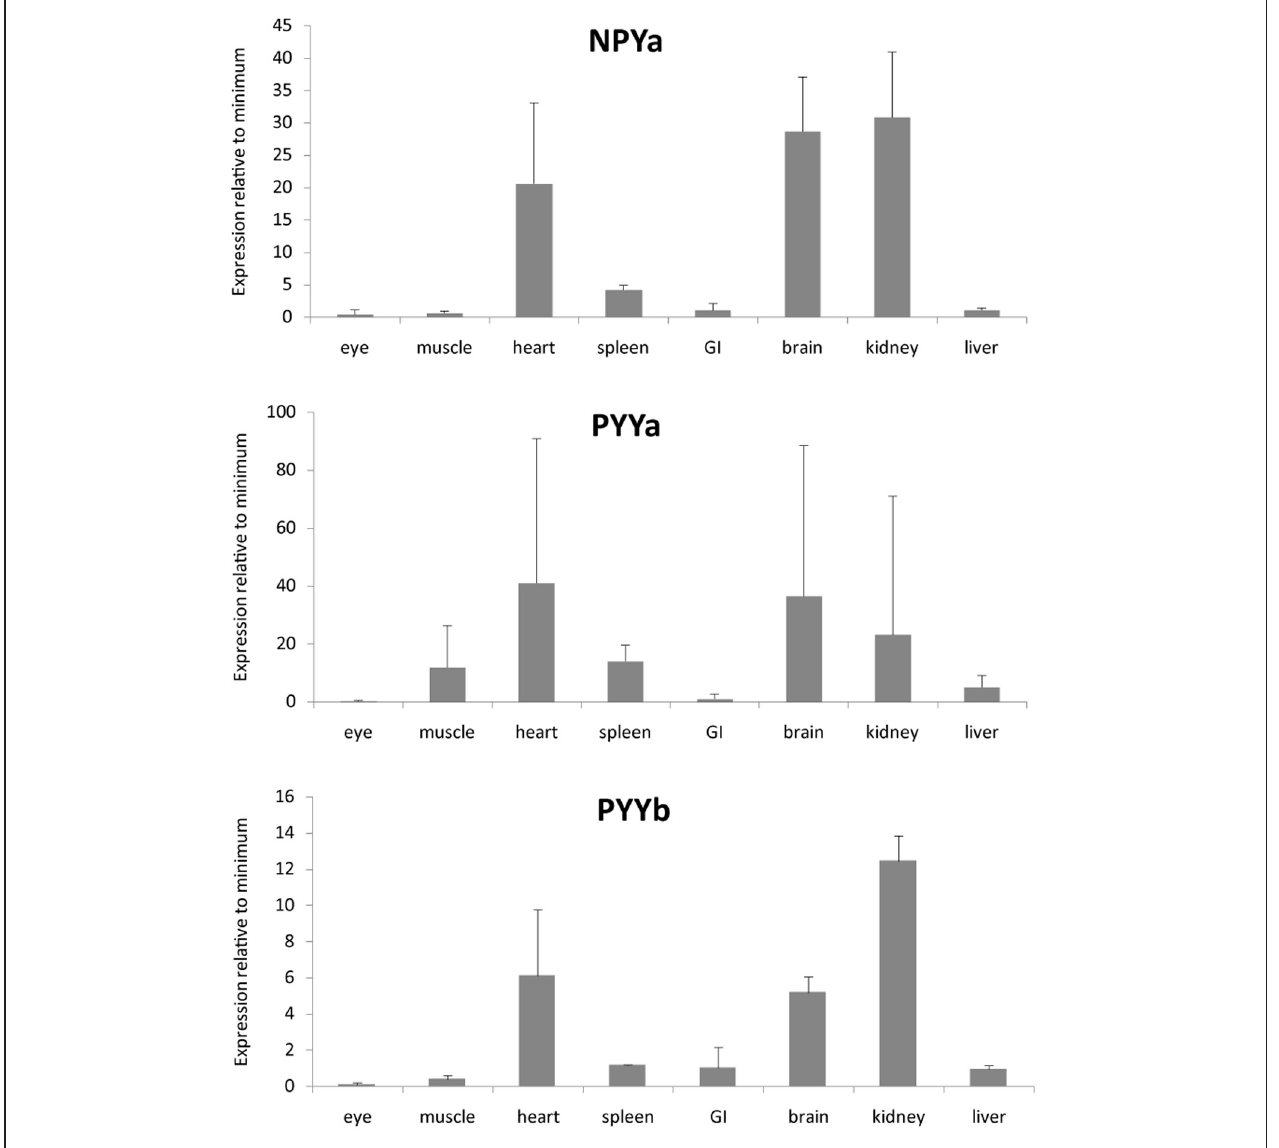
FIGURE 3 | Expression data for neuropeptide Y peptides in a panel of eight zebrafish organs. Error bars display the standard error of the mean. Normalized Ct values were used to calculate the relative expression values.